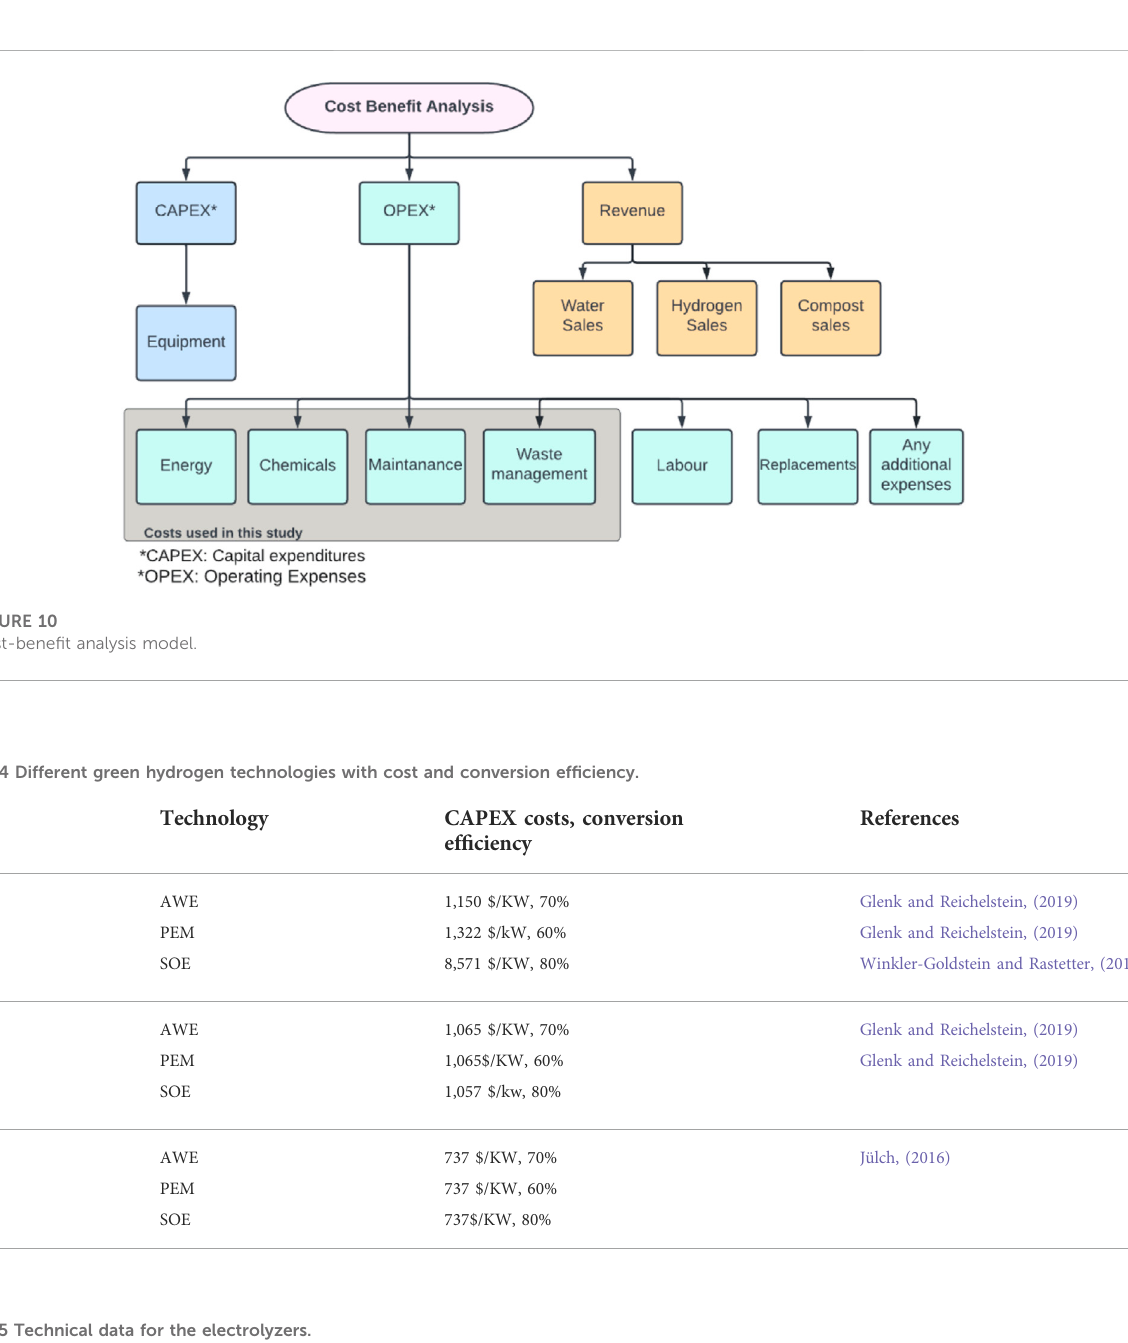
TABLE 5 Technical data for the